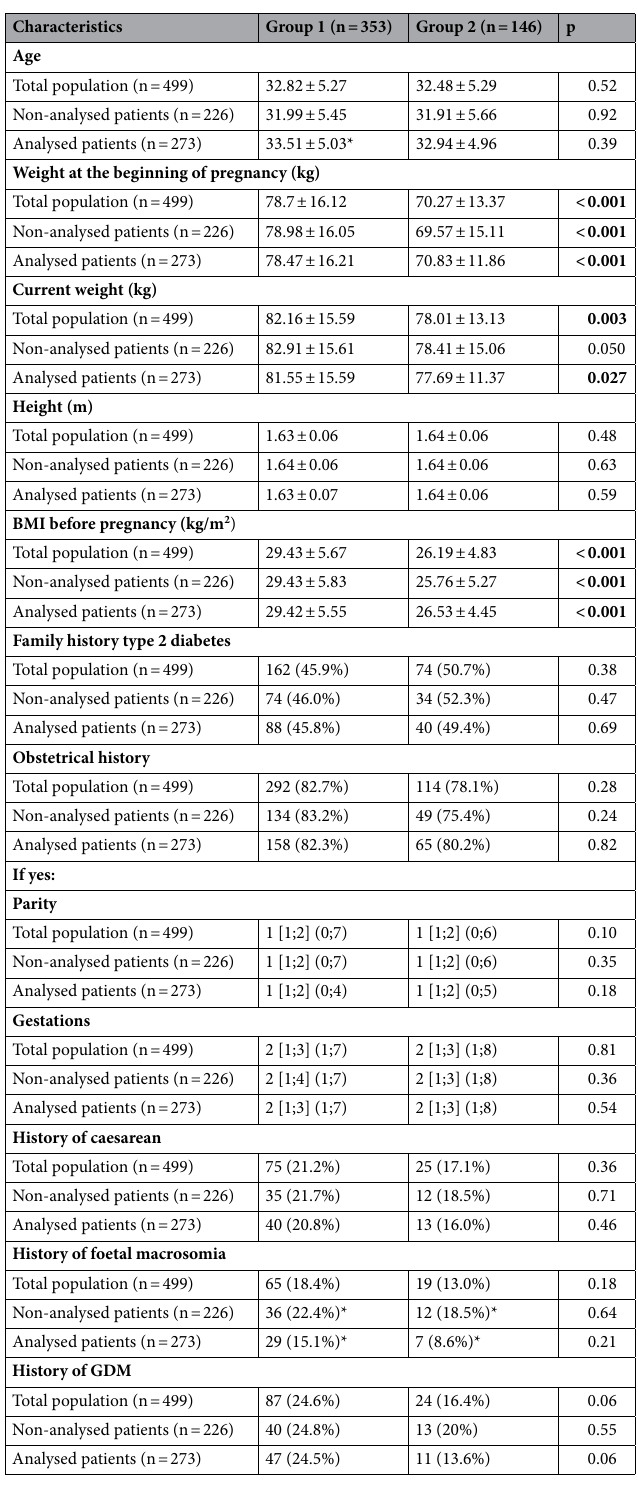
Table 1. Patient characteristics. Statistically significant p values between groups are given in bold. Data are presented as number (%), average ± standard deviation or median [Q1; Q3](min; max). *p < 0.05 for the comparison between Non-analysed and Analysed